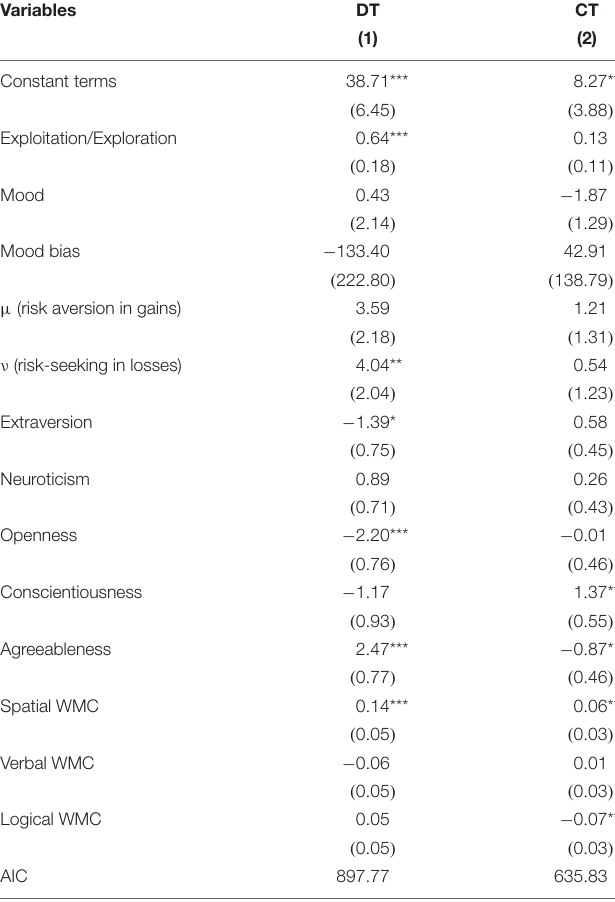
TABLE 4 | Simultaneous effects of mood and risk-taking (SE in